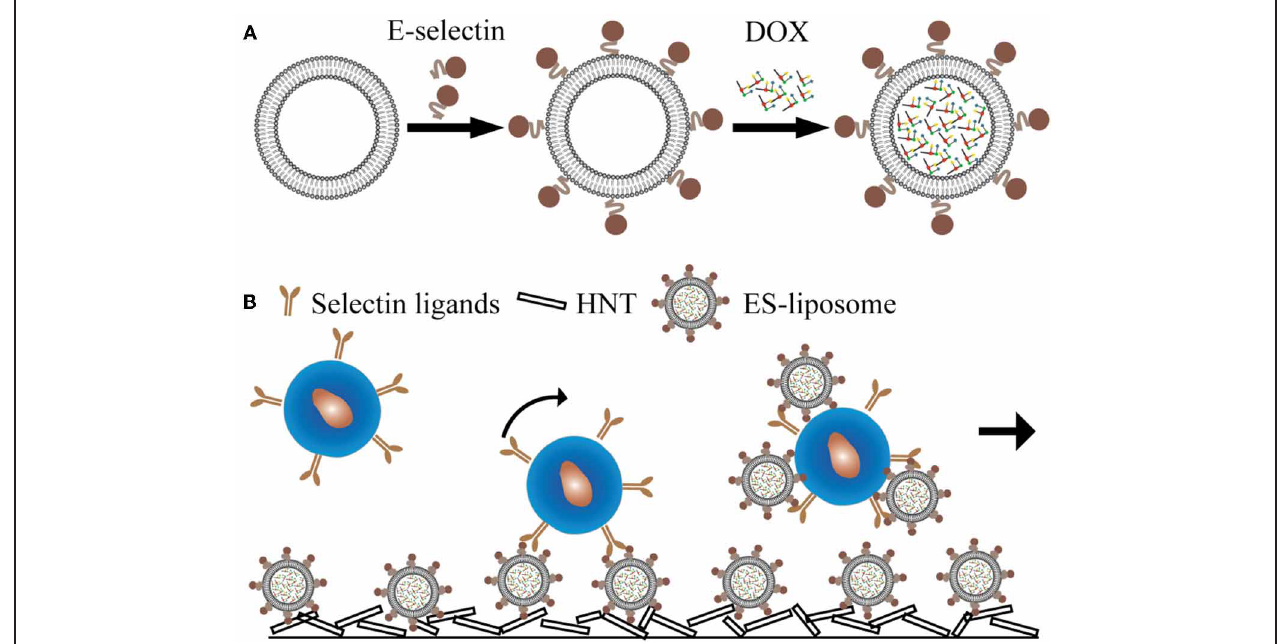
FIGURE 2 | E-selectin liposomal and nanotube-targeted delivery of doxorubicin to CTCs. (A) Schematic of E-selectin-coated liposome encapsulating doxorubicin (DOX). (B) Schematic of a microtube device for delivering DOX to captured CTCs.